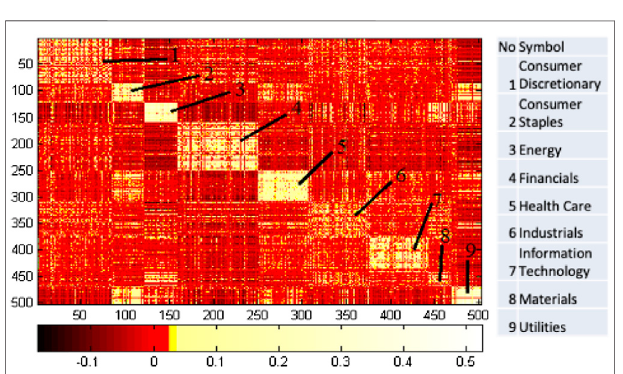
FIGURE 13 | The community detection results from the Cg correlation matrix mapping using the stock structure generated by the Simulated Annealing (SA) algorithm with parameters T 0 (cid:2) 0 and Δ T (cid:2) 0 . 01 and the maximum randomstep is 10. Group 1 is the consumer discretionary sector; group 2, namely the consumer staples sector; group 3, the energy sector; group 4, the fi nancial sector; group 5, namely the healthcare sector; group 6, the industrial sector; group 7, namely the information technology sector; group 8, the materials sector; and fi nally group 9, the utilities sector.